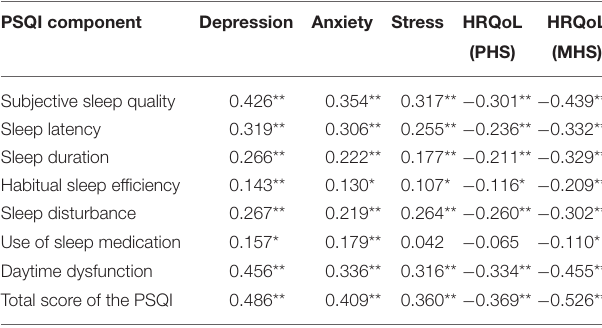
TABLE 3 | Correlations between sleep measures and relevant variables.